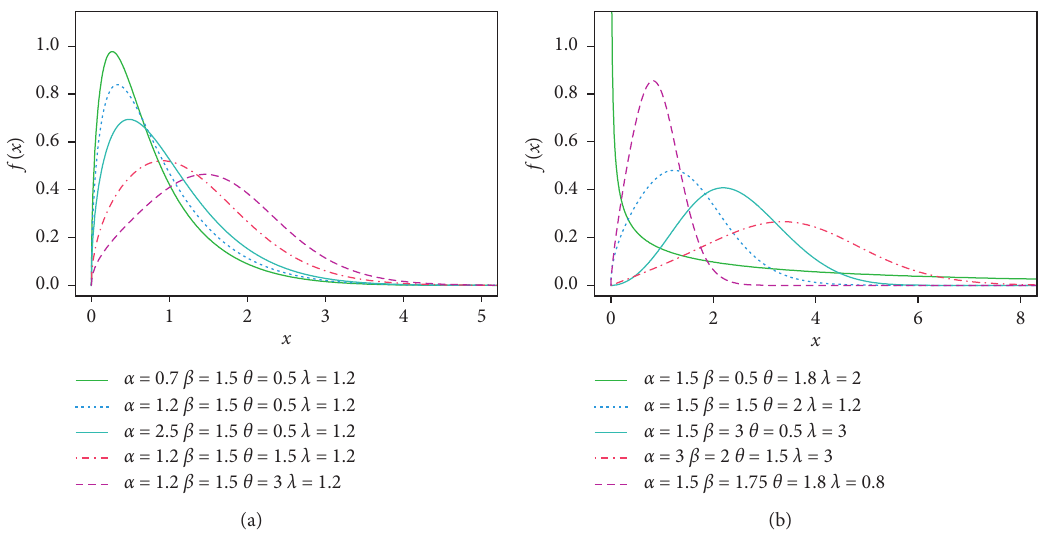
Figure 1: Plots of the PDF of the MOAPW with some values of parameters.